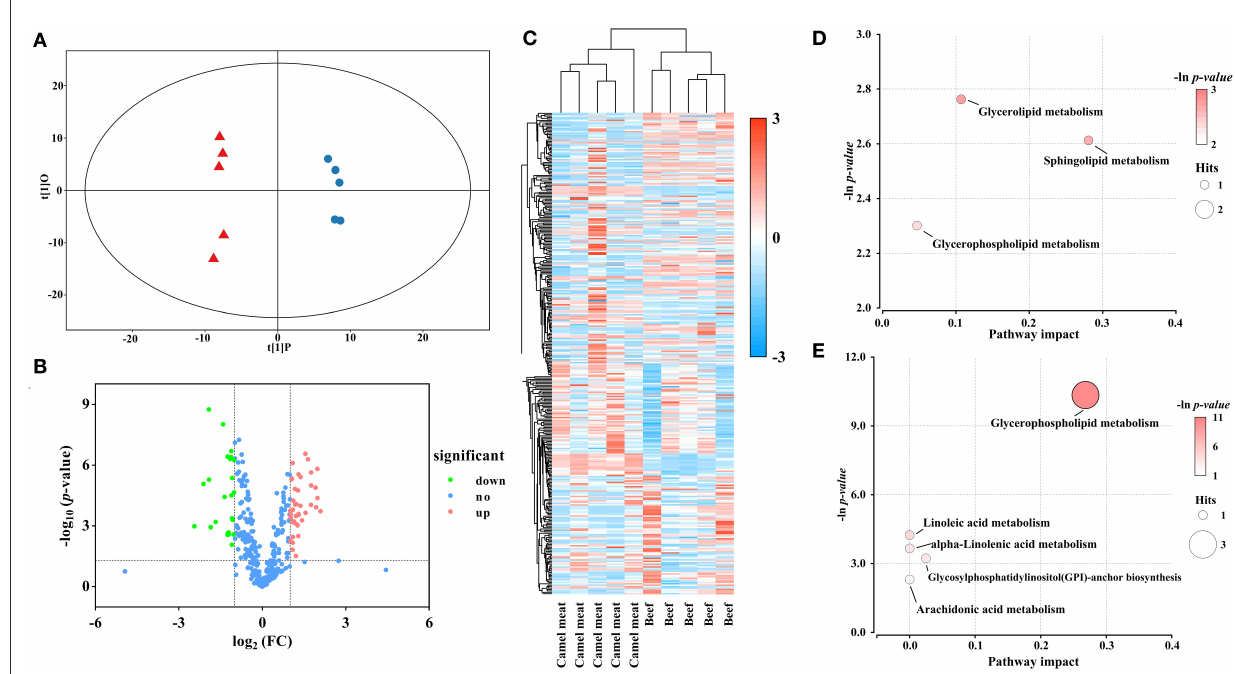
FIGURE4 Statistical analyses of lipids in camel meat vs. beef. (A) OPLS-DA scores plot. Blue circles represent camel meat, red triangles represent beef (R 2 Y = 0.995, Q 2 = 0.983). (B) Volcano plot using log 2 FC as the x-axis, -log 10 ( p < 0.05) as the y-axis, FC values were the ratios of lipid content in camel meat to that in beef. (C) Heat map and hierarchical clustering of differential abundance lipids between camel meat and beef. To build the heat map, normalized abundances were used; the red color represents high abundance, whereas the blue color represents low abundance. Bubble plots of KEGG pathway analysis in positive (D) and negative (E) ionization mode, and the supplementary data showed in Supplementary material